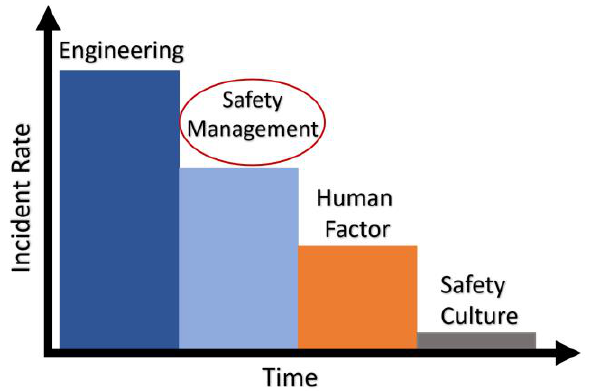
Figure 1. Role of safety culture in reducing incidents ’ rate.